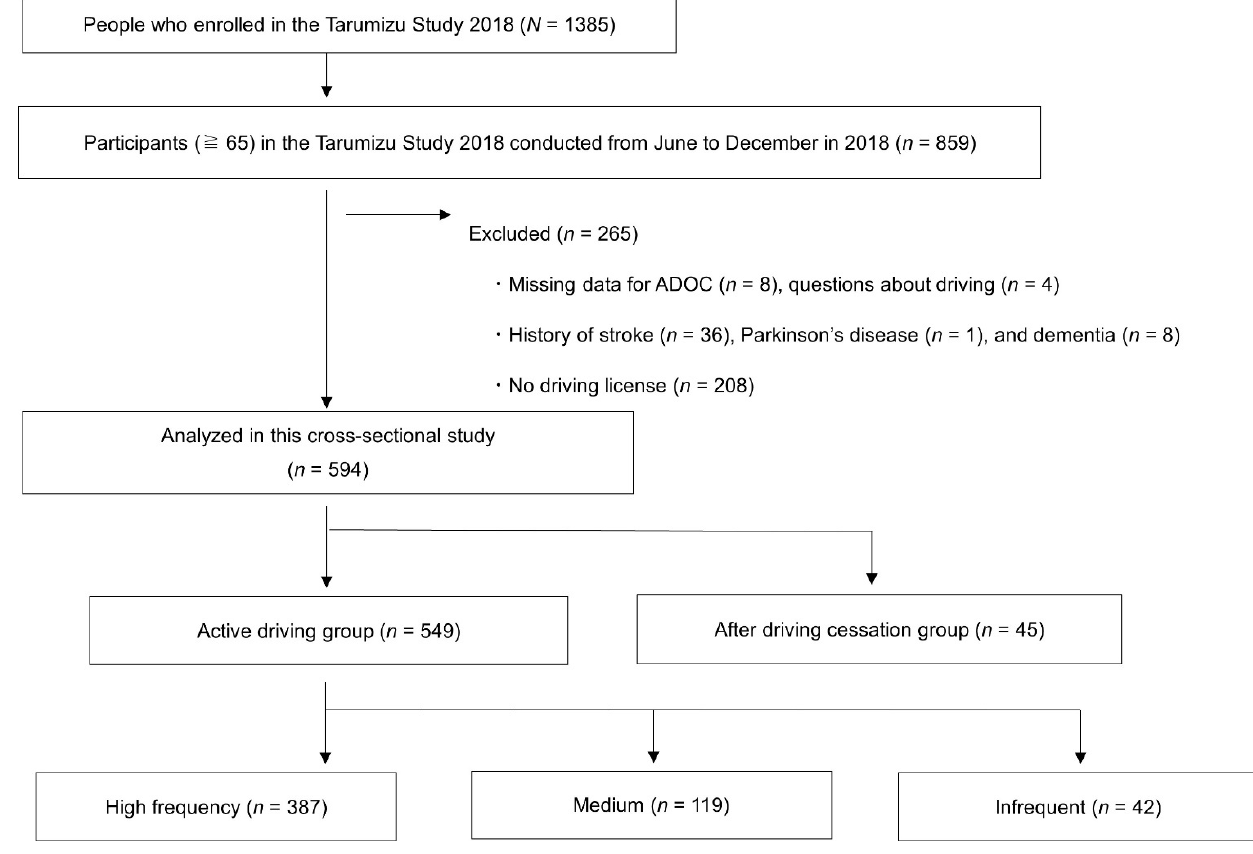
Figure 1. Flowchart of the present study.